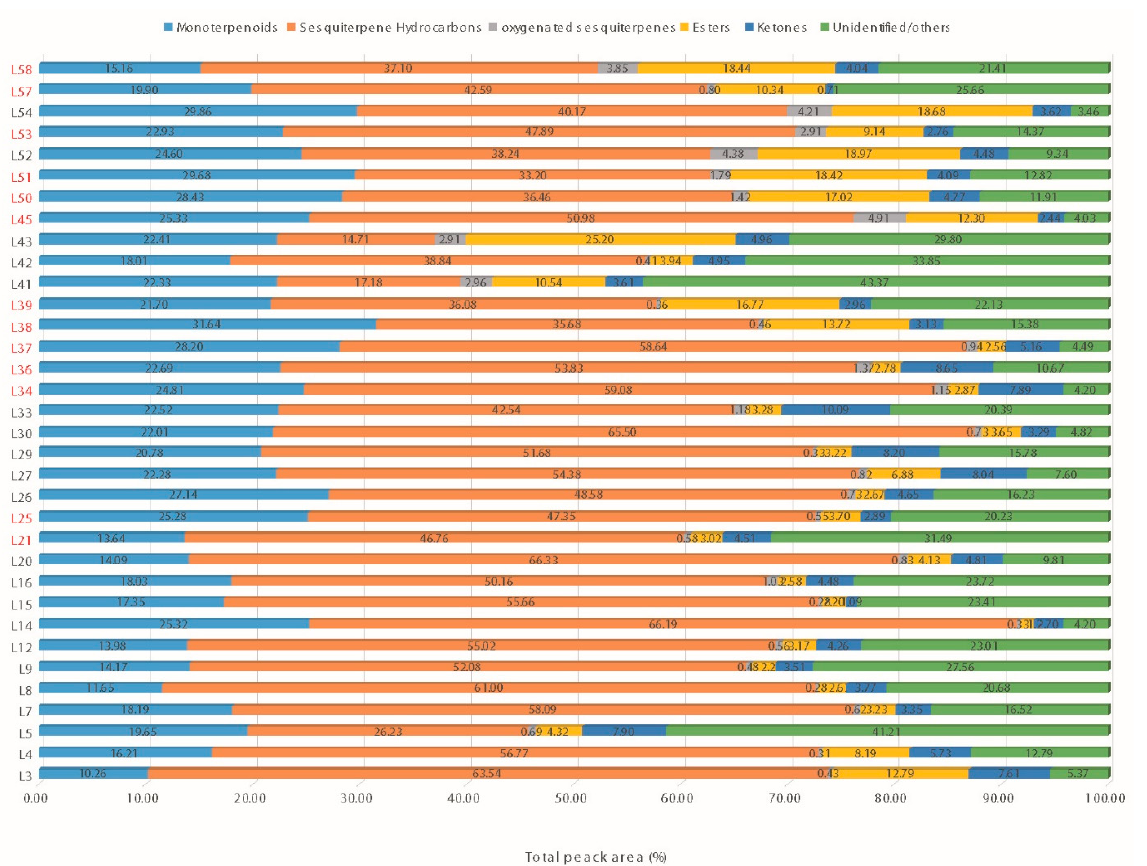
Figure 2. Relative composition of the 34 accessions divided into 6 compound classes. The number on bars are referred to mean % value of the two year analysis. Trentino Alto Adige accessions are indicated in red.